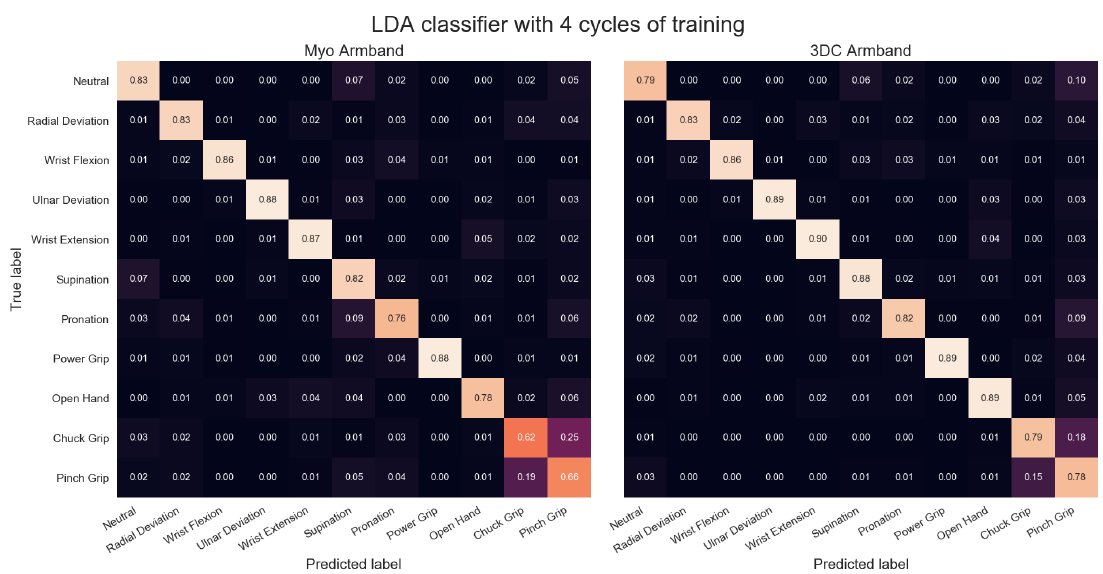
Figure 12. Confusion Matrices for the Myo and the 3DC Armband employing linear discriminant analysis (LDA) for classification and four cycles of training. A lighter color is